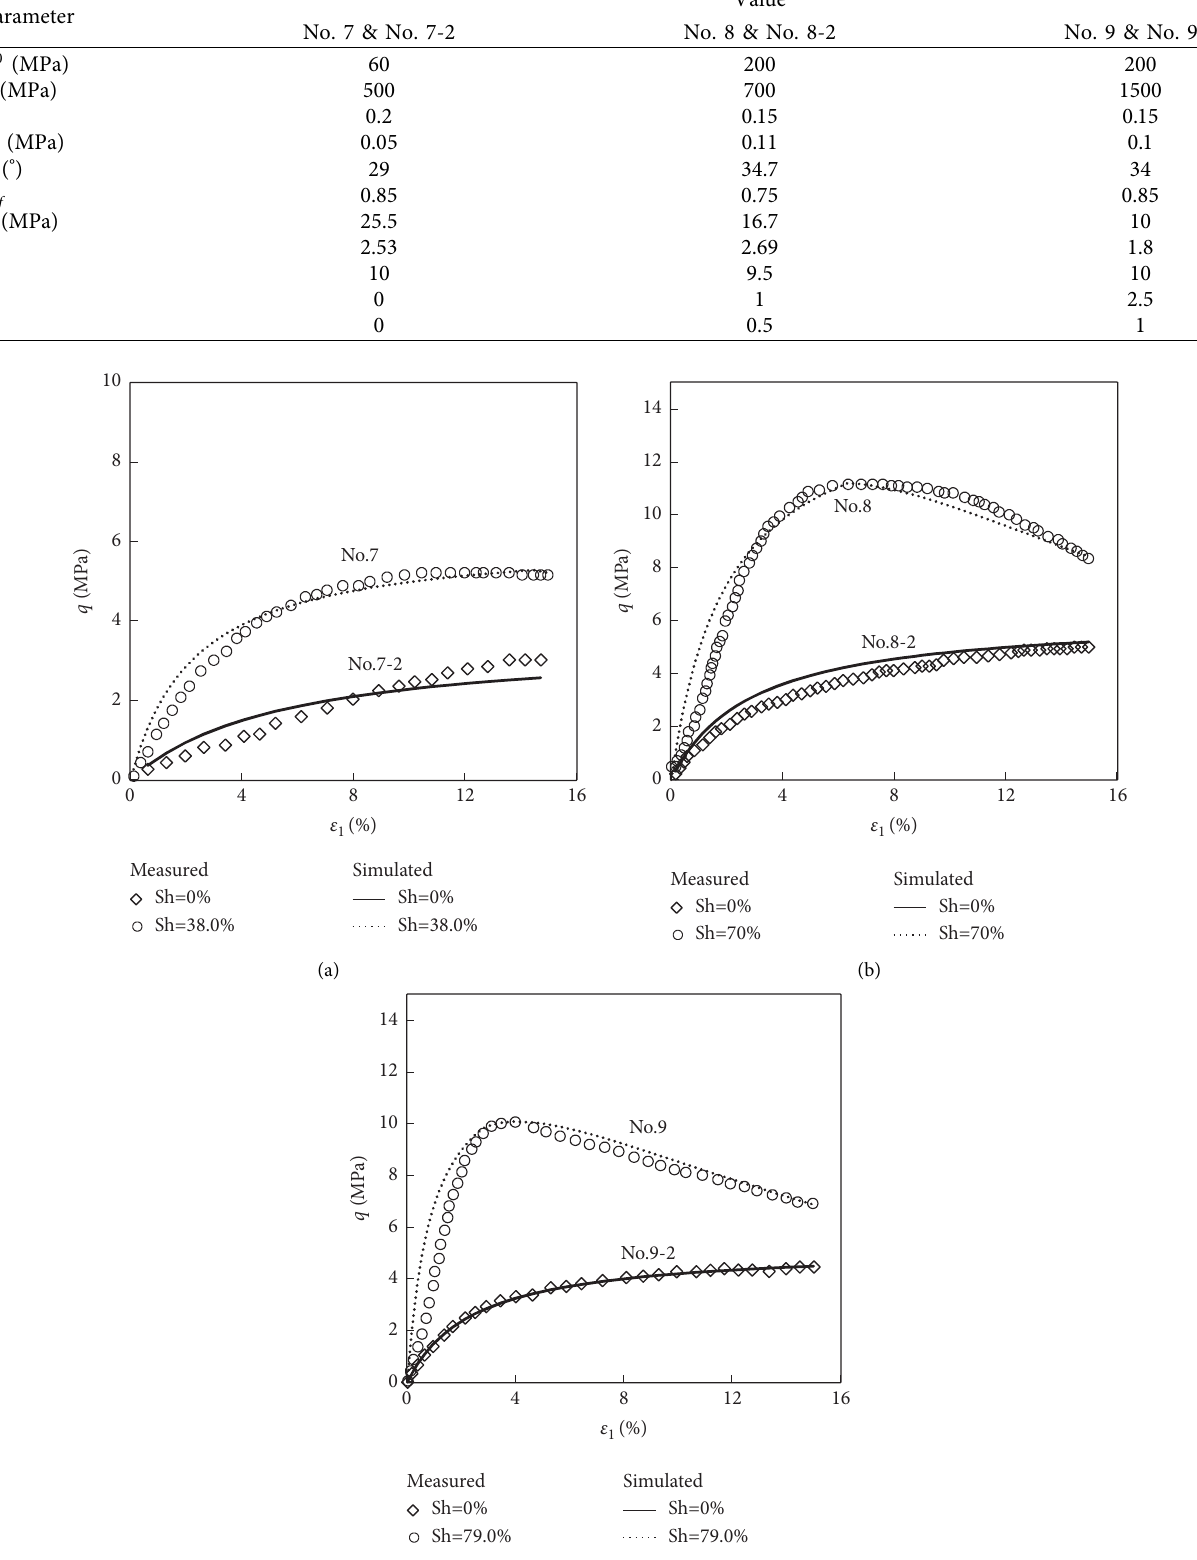
Table 5: Model parameters.